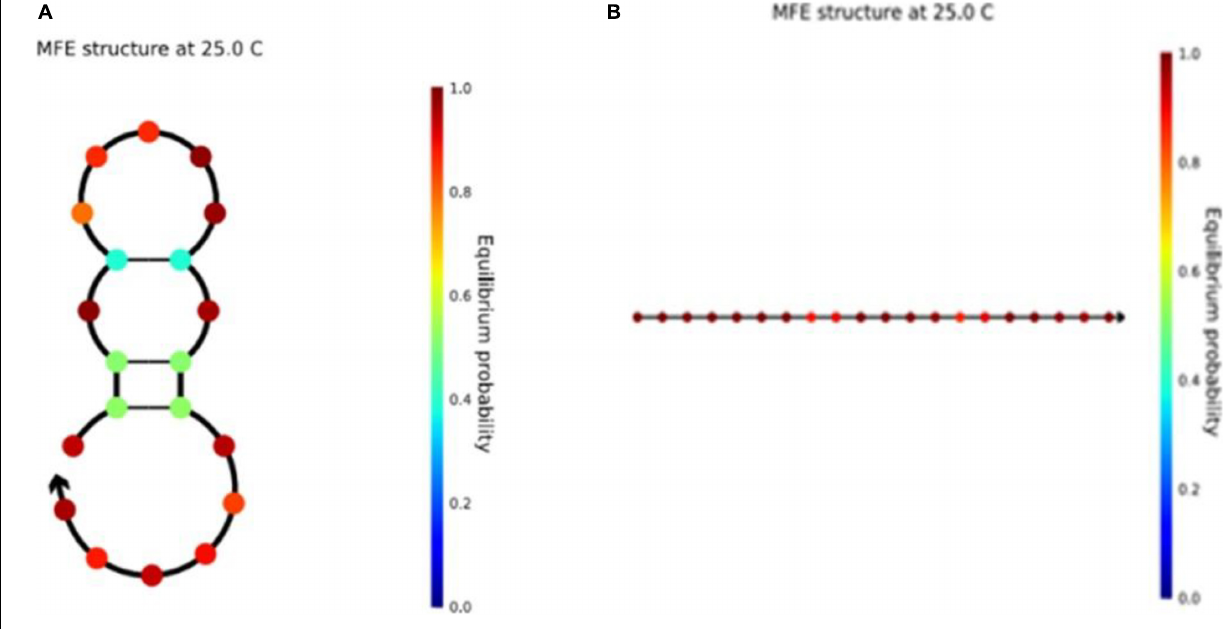
FIGURE 10 | (A) The structure of sequence ACAGTCGTTAAATGGGAGTC in NUPACK. (B) The structure of sequence CCTCTCCATCCTTATCCTTC in